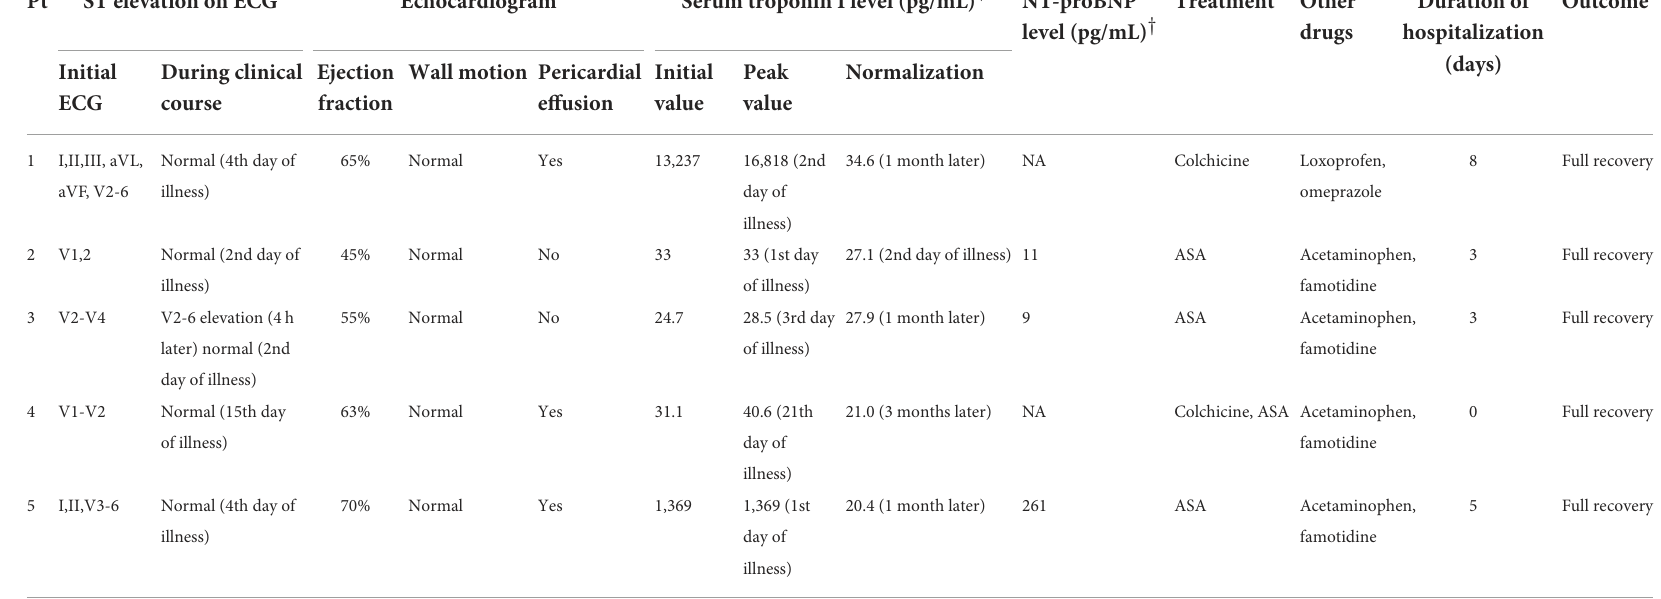
TABLE 2 Electrocardiogram, echocardiogram, laboratory